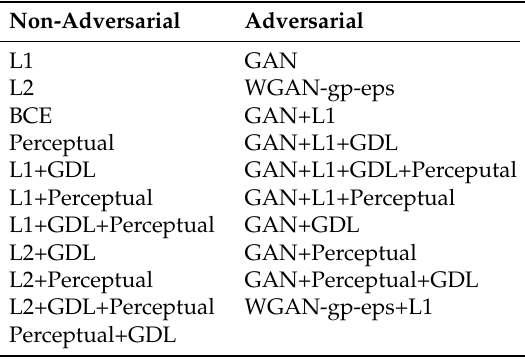
Table 1. Loss combinations for training.